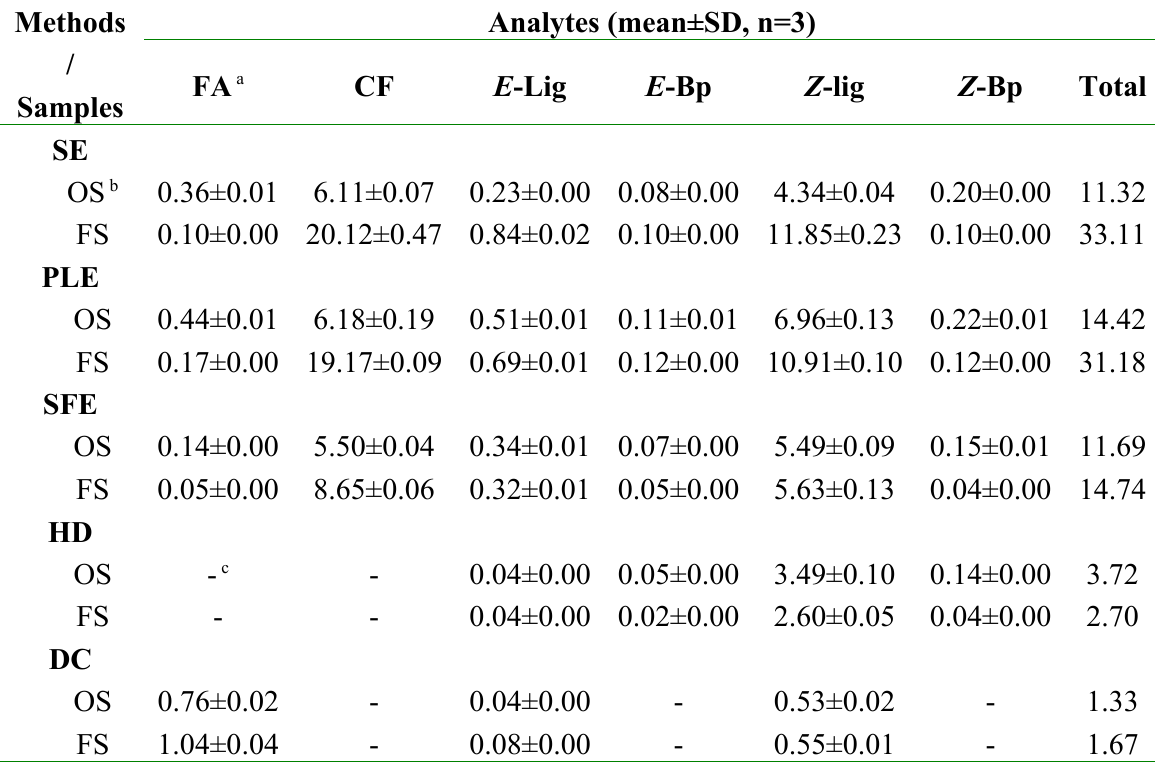
Table 1. Extractable contents (mg/g) of six compounds in Angelica sinensis using sonication (SE), pressurized liquid extraction (PLE), supercritical fluid extraction (SFE), hydrodistillation (HD) and decoction